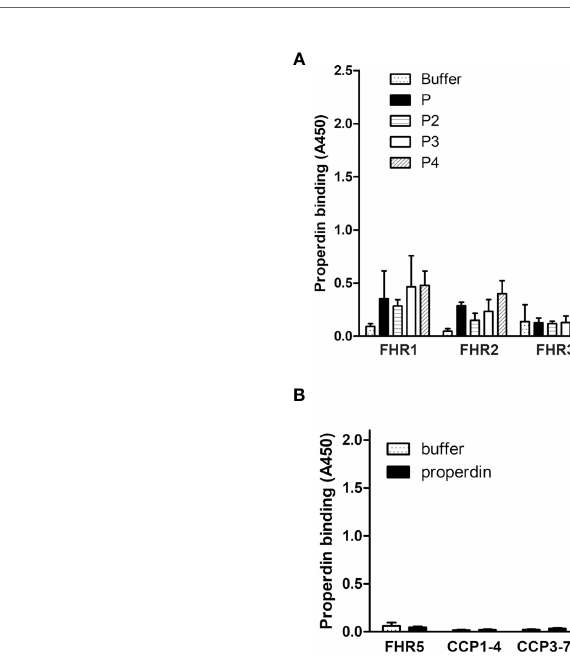
FIGURE 6 | Analysis of properdin binding to FHRs. (A) The fi ve FHR proteins, C3b as positive control protein and HSA as negative control protein were immobilized and binding of puri fi ed properdin (P) and the isolated properdin dimers, trimers and tetramers (P2, P3 and P4, respectively) was measured by ELISA using anti- properdin antibody. (B) Properdin binding to the FHR5 deletion mutants CCPs 1-4, 3-7 and 8-9 was measured as in (A) . Data are means + SD from three experiments. ***p <0.001, one-way ANOVA, compared to the negative control protein HSA.